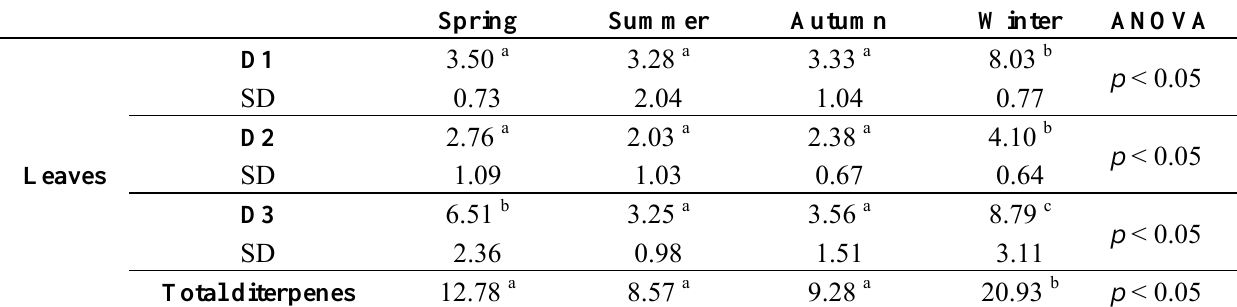
Table 1. Amounts (mg/g dry-w) of diterpenes (D1: diterpene 1; D2: diterpene 2; D3: diterpene 3) in leaves collected in autumn, winter, spring, and summer in the selected populations. The values are the means of the four populations studied over two years. SD: standard deviation.